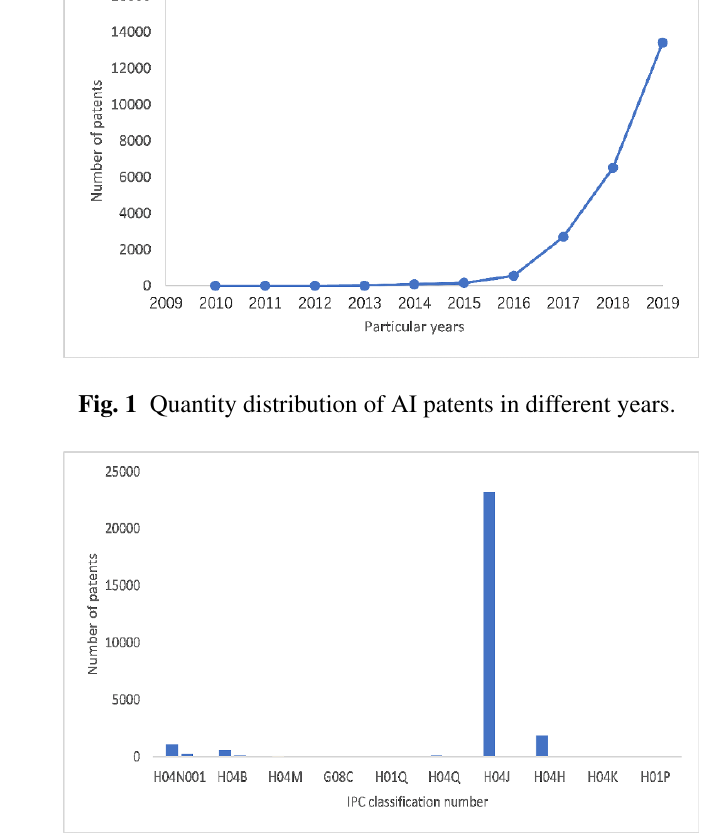
Fig. 2 IPC distribution of AI